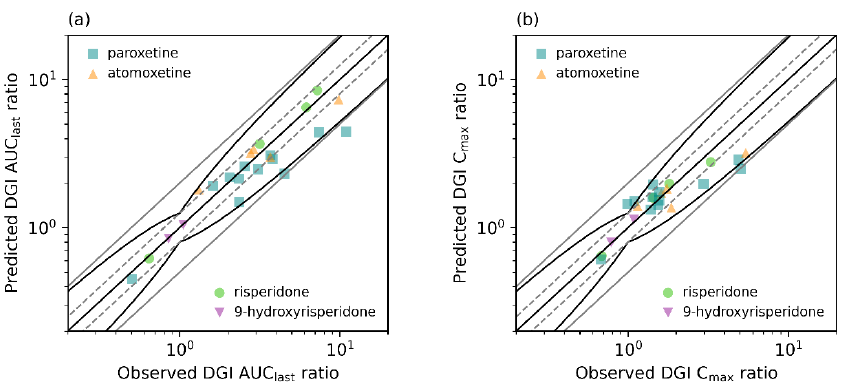
Figure 6. Comparison plot of predicted versus observed ( a ) DGI AUC last ratios and ( b ) DGI C max ratios for all analyzed CYP2D6 DGI studies. The straight black line indicates the line of identity, curved black lines show prediction success limits proposed by Guest et al., including 1.25-fold variability [58]. Solid gray lines indicate two-fold deviation, dashed gray lines show 1.25-fold deviation. AUC last : area under the plasma concentration–time curve from the time of the first concentration measurement to the time of the last concentration measurement, C max : maximum plasma concentration, and DGI: drug–gene interaction.